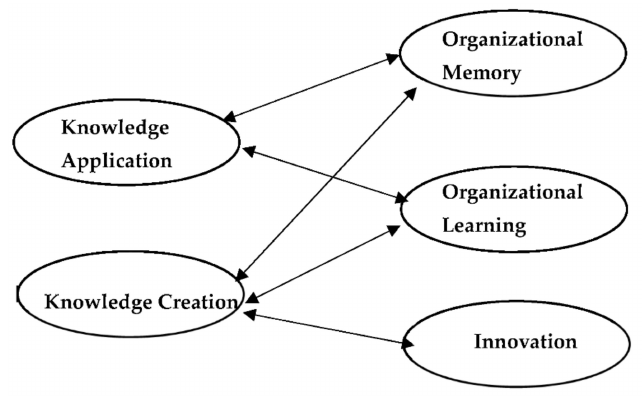
Figure 4. Relationship between creation and application of knowledge and innovation. Source: